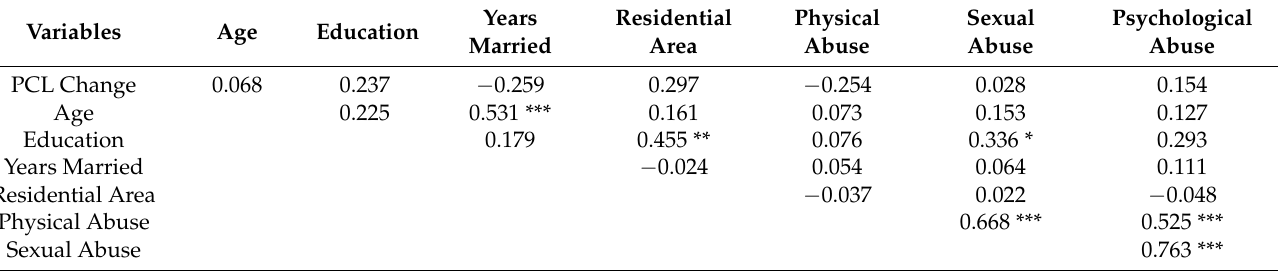
Table 2. Spearman correlations among predictor variables and PCL change